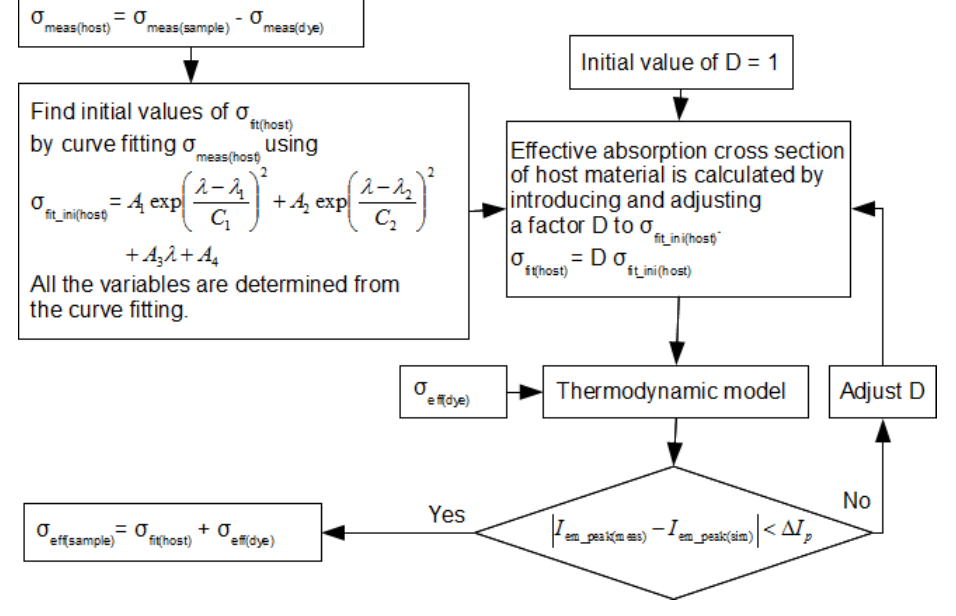
Figure 12. Flow chart for calculating the effective absorption cross section of the